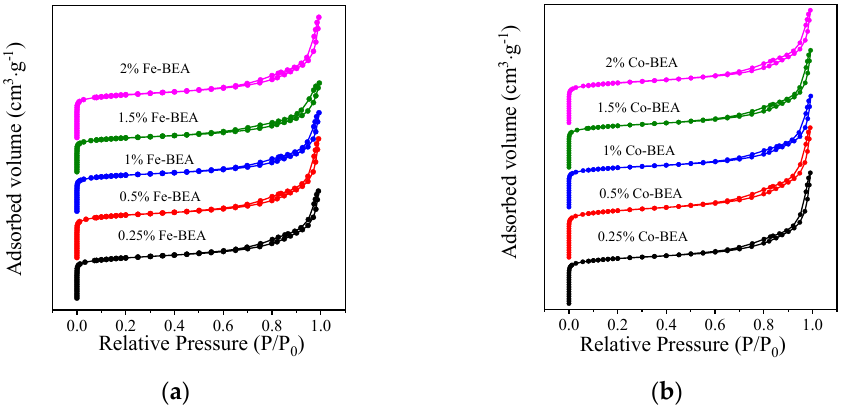
Figure 2. ( a ) N 2 adsorption–desorption profiles of Fe-BEA with different concentrations; ( b ) N 2 adsorption–desorption profiles of Co-BEA with different concentrations.